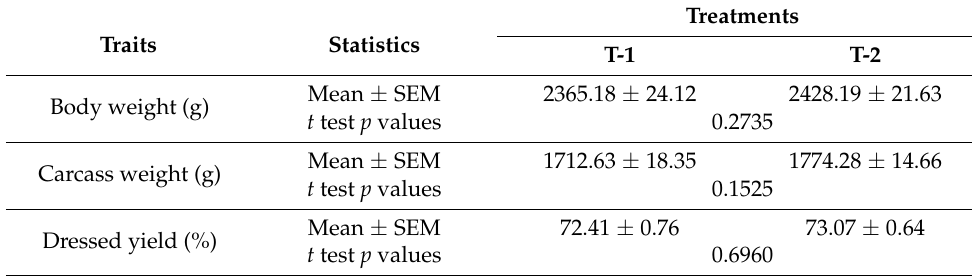
Table 7. Dressed yield.